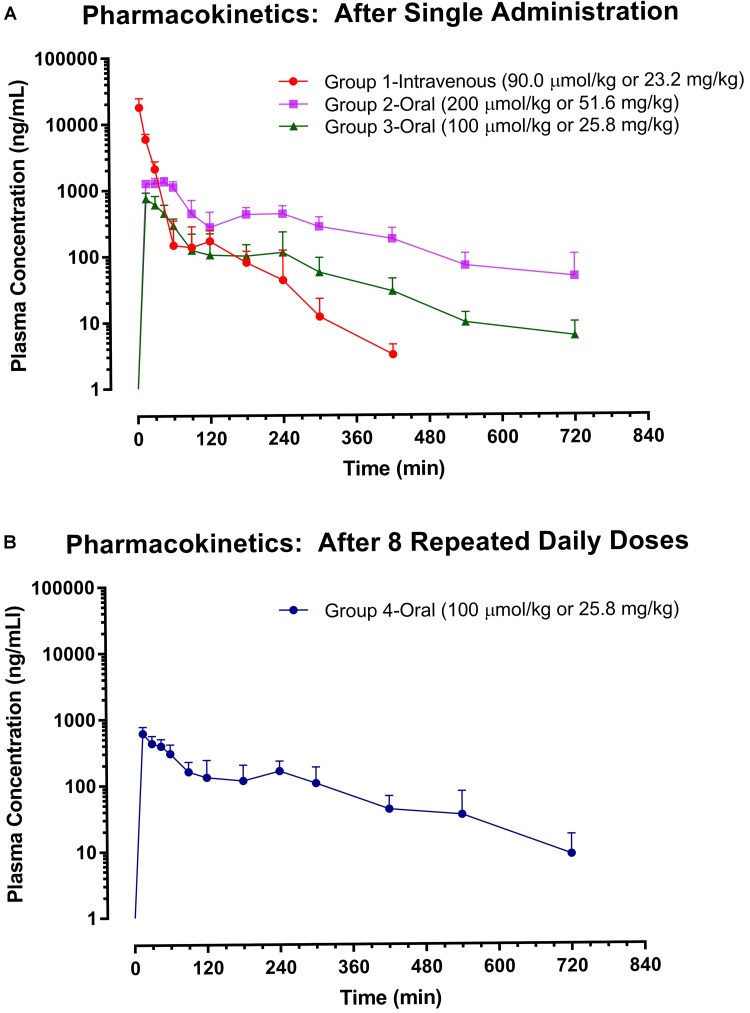
Pharmacokinetics of isorhapontigenin. Plasma isorhapontigenin levels were measured with LC–MS/MS. Symbols represent mean concentrations and error bars represent SD. (A) Groups 1 – 3: n = 5; except Group 2 at 720 min where n = 4. (B) Group 4: n = 7.